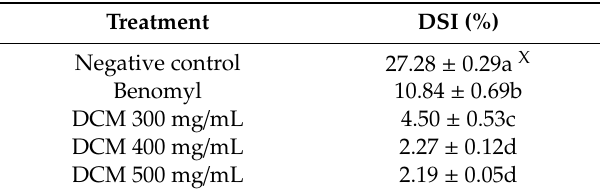
Table 3. Percentage of disease severity index on tomato treated